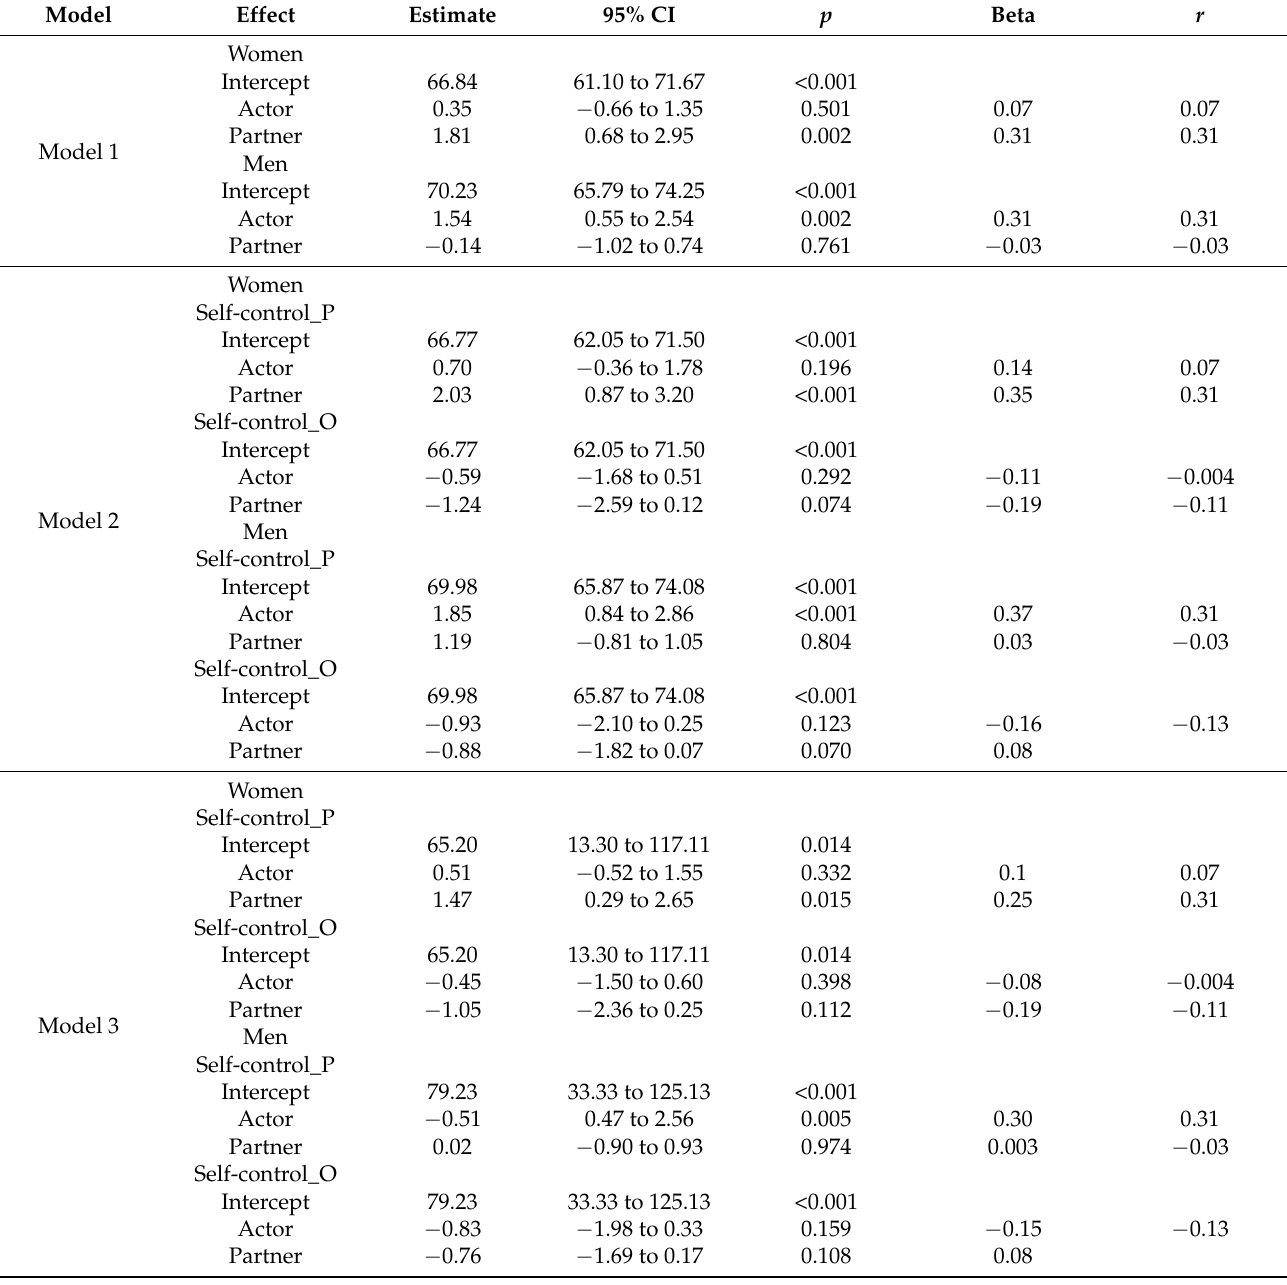
Table 3. Actor and partner effects of perceived partner’s self-control on relationship